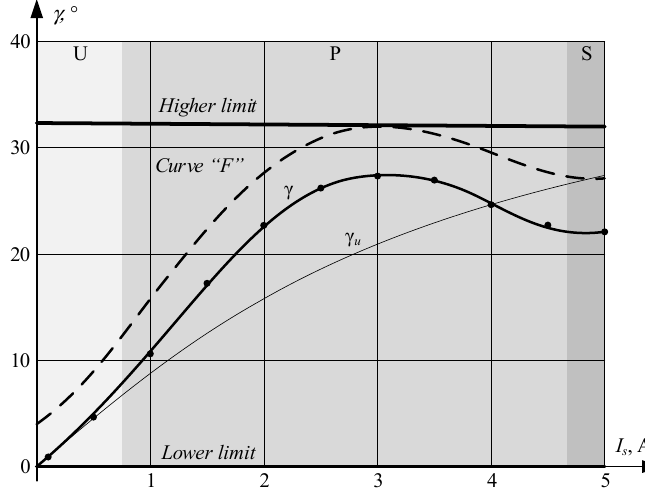
Figure 14. Constraints design for MTPA angle γ using fixed limits.